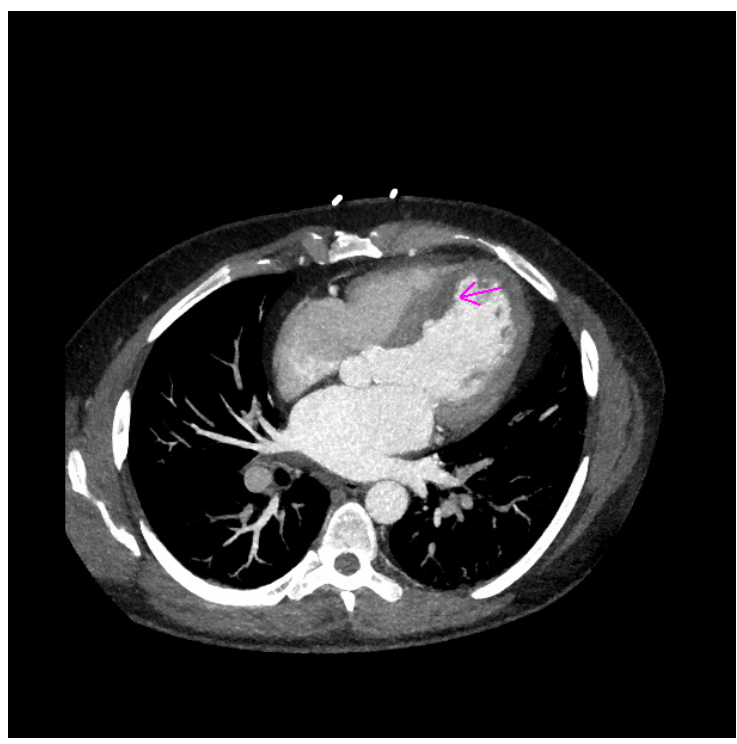
Figure 4. CT finding of first thrombus in the area of left ventricular apex (purple arrow).